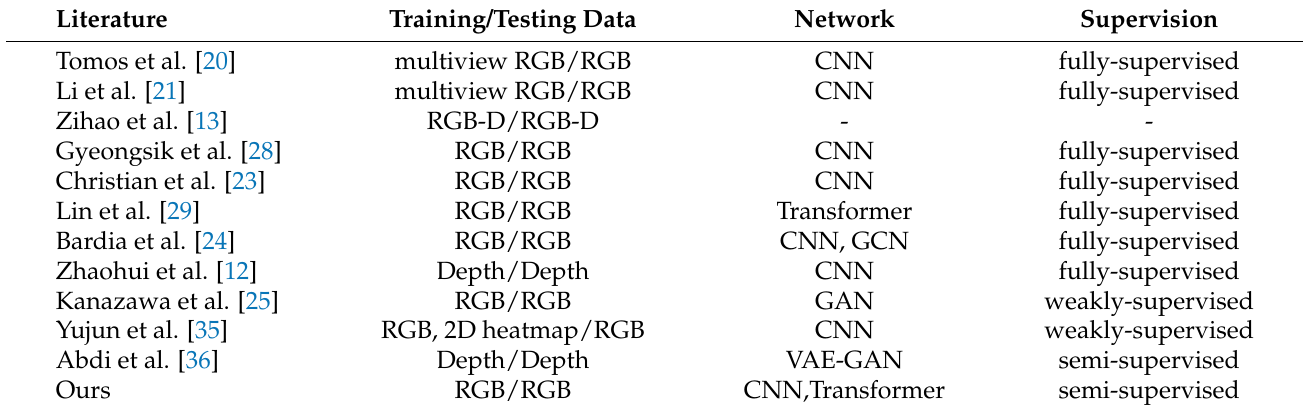
Table 1. Summary of problem settings in related 3D hand pose estimation